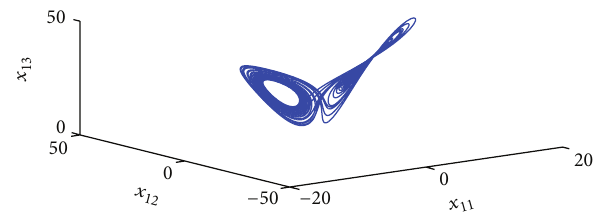
Figure 1: Chaotic attractors of fractional-order Lorenz system (25) for 𝑞 𝑑1 = 0.994 .